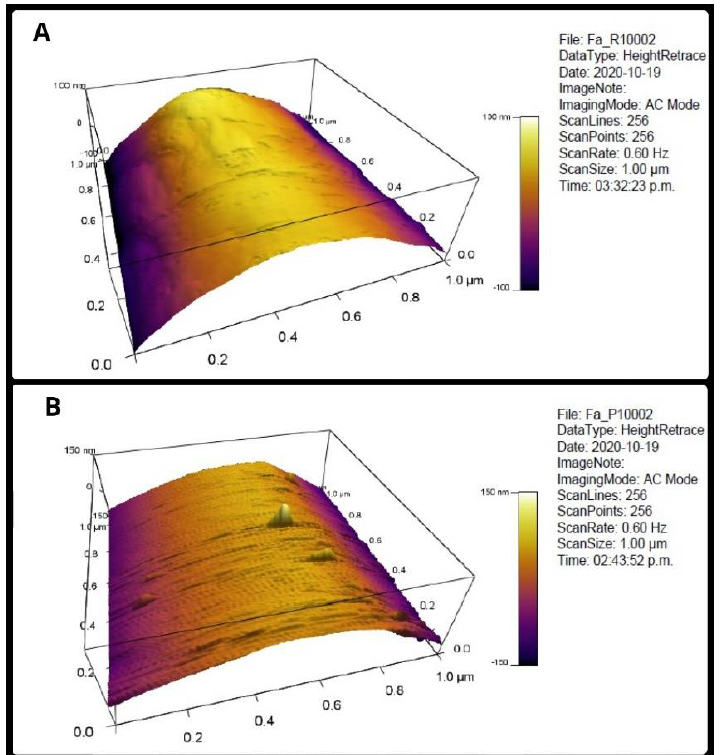
Membranes 2022 , 12 , x FOR PEER REVIEW Figure 2. AFM of PCL fibers. ( A ) is for the RC scaffold, ( B ) for the XYP Scaffold. AFM: atomic force microscope, XYP: flat collector platform with movements in the X and Y axes, RC: rotary collector. Table 1. Surface roughness of the samples collected using the RC and XYP.